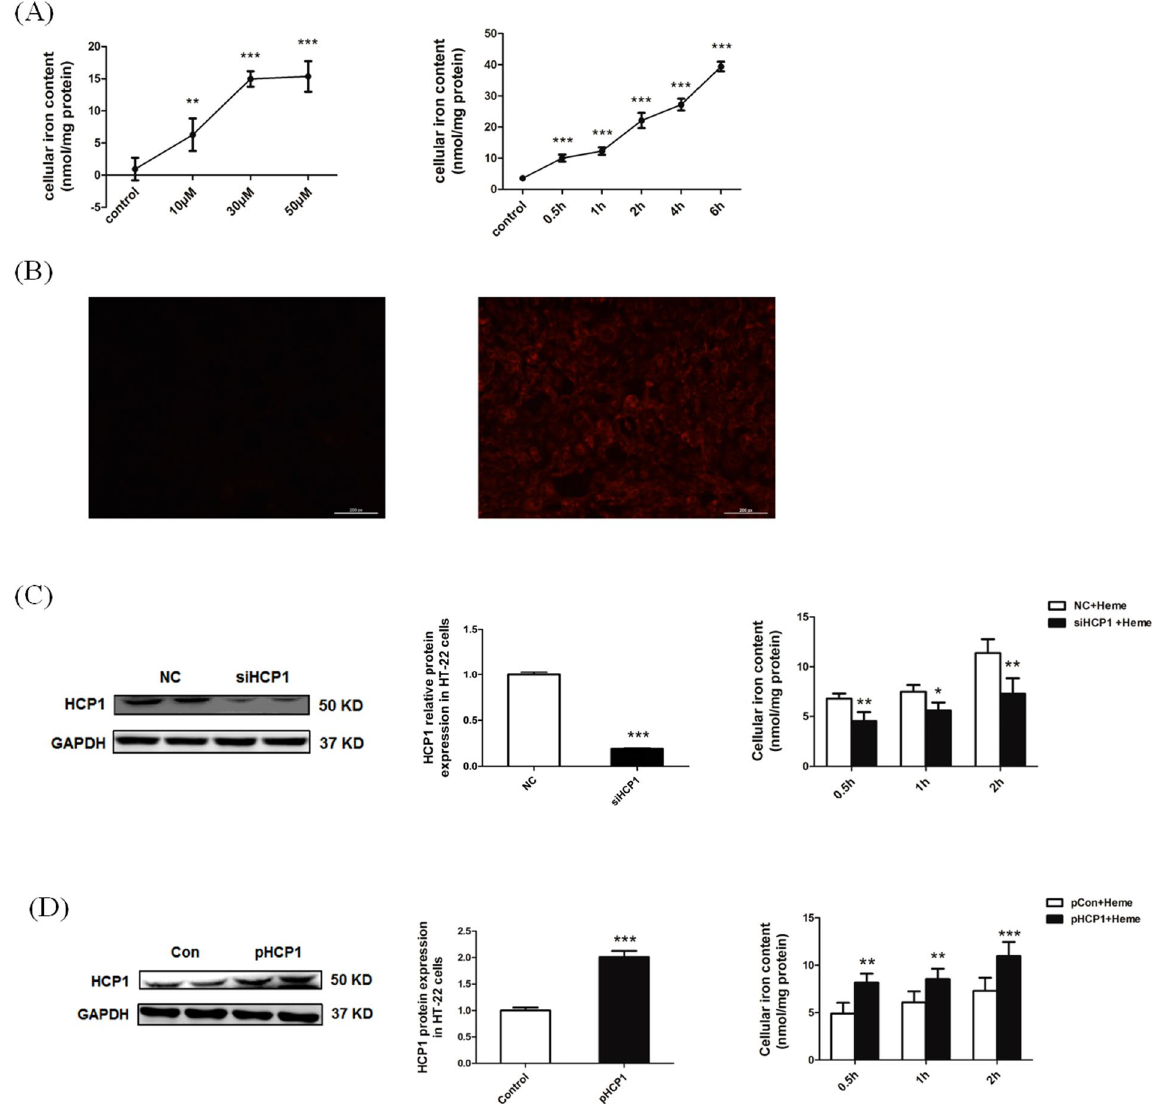
Figure 2. Mouse hippocampus nerve cells have the capacity to uptake heme via HCP1. ( A ) Iron content in cells treated with different concentrations of heme for 2 h and with 30 μ M heme for different time. ( B ) To visualize hemin accumulation in neurons, cells were incubated with 30 µ M ZnPPIX for 2 h, and the fluorescence in ZnPPIX treated cells was apparently intensified and compared with the control. ( C )The expression of HCP1 was decreased when cells were transfected with HCP1 siRNA, and the uptake of heme was correspondingly decreased. ( D ) The expression of HCP1 was increased when cells were transfected with HCP1 expression plasmid, and the uptake of heme was correspondingly increased. Values are means ± SD. * p < 0.05; ** p < 0.01; *** p <